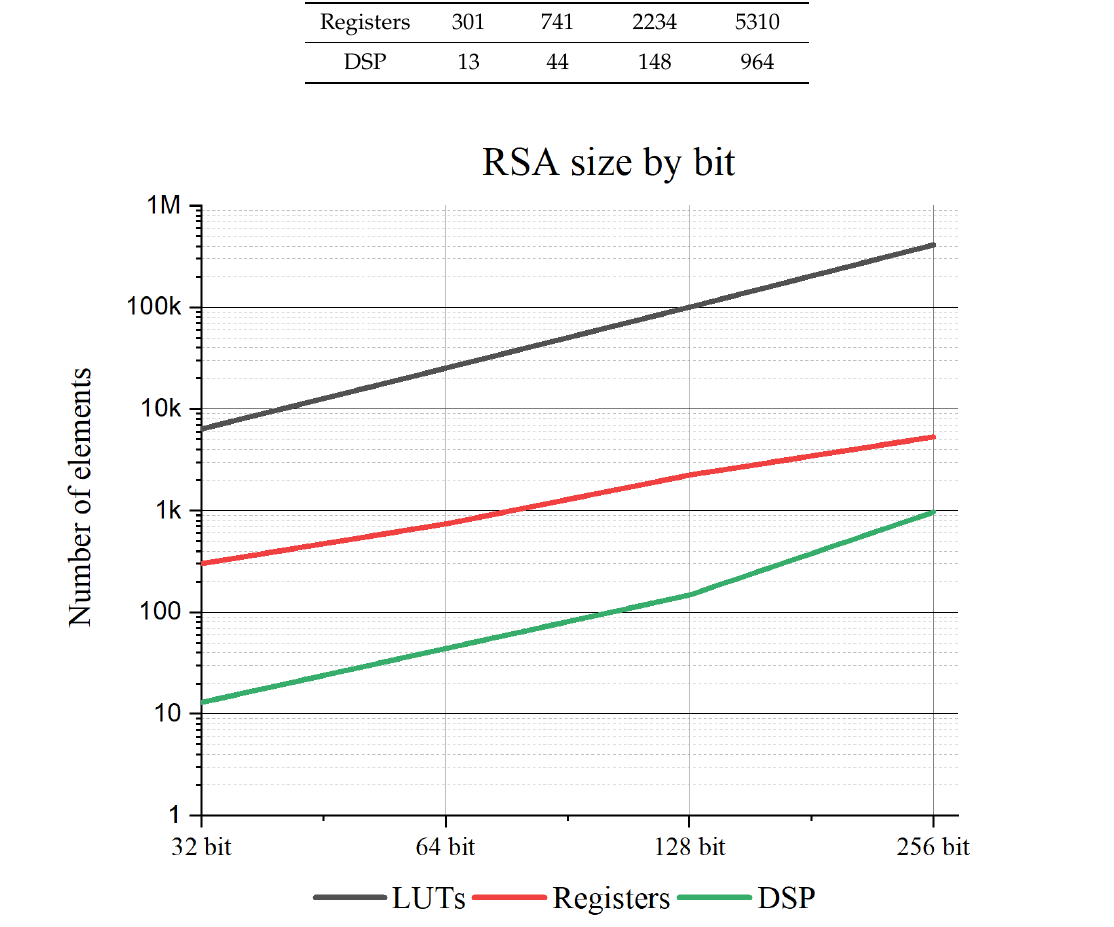
Figure 6. RSA size by bit